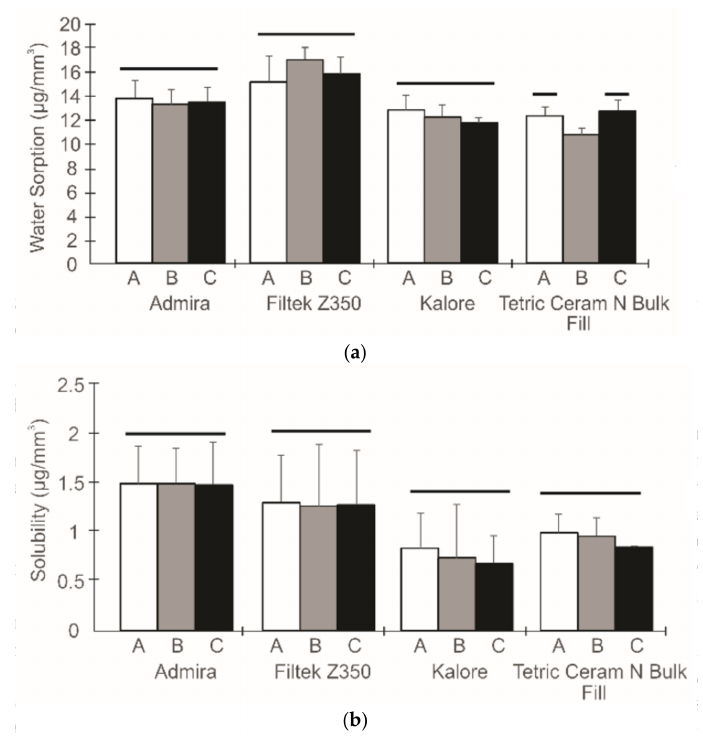
Figure 2. The water sorption ( a ) and the solubility ( b ) from different curing protocols. The columns under the same horizontal line are not statistically